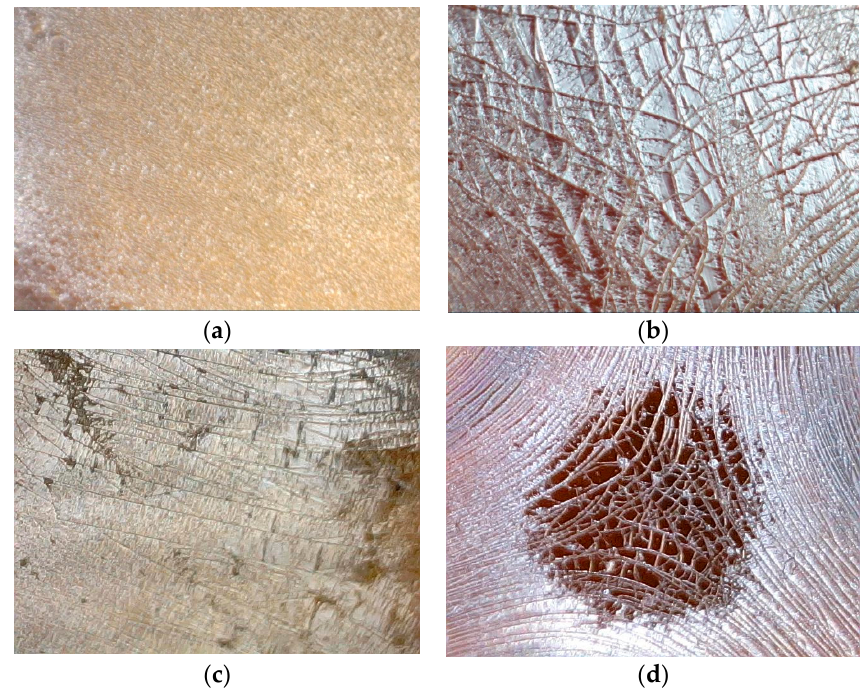
Figure A5. Optical microphotograph (2 × 1.5 mm) of EPDM rubber after 10 15 ions/cm 2 PIII. ( a – d ) are in a center of the treated area.